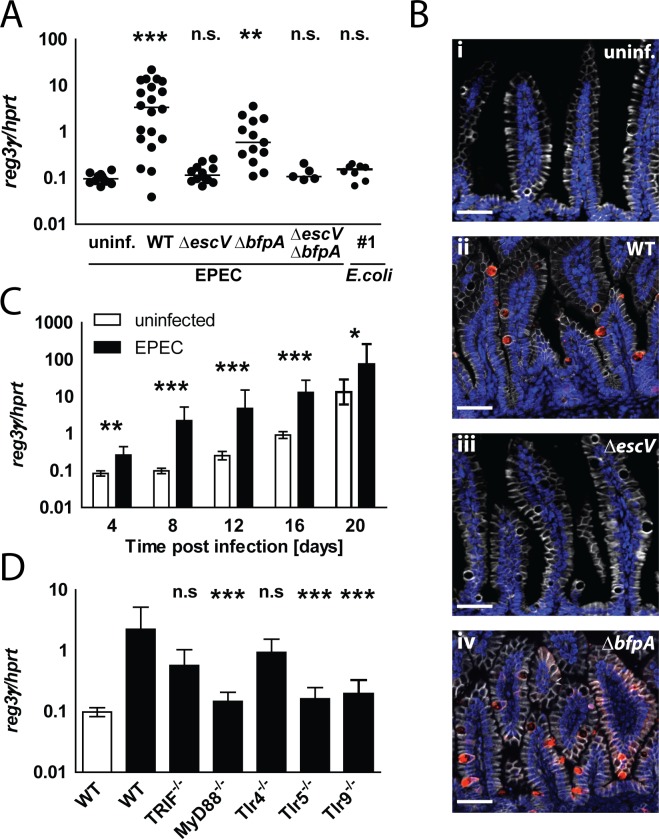
Analysis of bacterial and host factors required for the EPEC-induced epithelial response.
(A) 1-day-old mice were orally infected with WT EPEC, escV mutant, bfpA mutant, escV/bfpA double mutant EPEC, a murine commensal E. coli strain or left untreated. IEC were isolated 8 days p.i. and the expression level of RegIIIγ was determined and normalized to the values obtained for hprt (n = 4–16 from at least 2 litters; median). (B) Immunostaining for RegIIIγ in the distal part of the small intestine of 9-day-old untreated control animals (i) or mice infected at birth with WT (ii), escV mutant (iii), or bfpA mutant EPEC (iv) at 8 days p.i. (RegIIIγ, red; E-cadherin, white; DAPI, blue; bar = 50 μm). (C) Time kinetic of the epithelial RegIIIγ expression in infected neonates and age-matched controls. 1-day-old mice were orally infected with WT EPEC (black bars) or left untreated (white bars). IEC were isolated at 5, 9, 13, 17 and 21 days after birth and the expression of RegIIIγ was measured and normalized to hprt (n = 7–17 from at least 2 litters; geometric mean ± 95% confidence interval). (D) 1-day-old C57BL/6 WT, MyD88-/-, TRIF-/-, Tlr4-/-, Tlr5-/- and Tlr9-/- mice were orally infected with WT EPEC (black bars) or left untreated (white bars) and the epithelial RegIIIγ expression was measured and normalized to hprt (n = 11–27 from at least 2 litters; geometric mean ± 95% confidence interval). Kruskal-Wallis ANOVA with Dunn’s multiple comparison post-test (A and C-D). ns, p>0.05; *, p<0.05; **, p<0.01; ***, p<0.001.